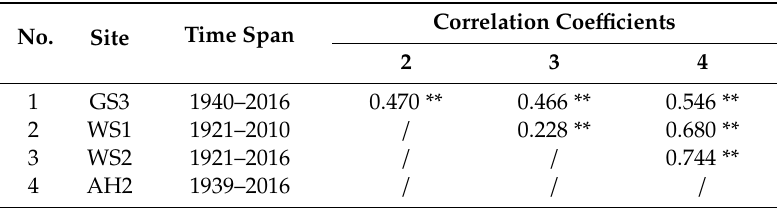
Table 5. Site information and Pearson’s correlation coefficients for the common period of 1921–2016 for tree-ring δ 13 C chronologies of Picea schrenkiana (spruce) from the Ili region.